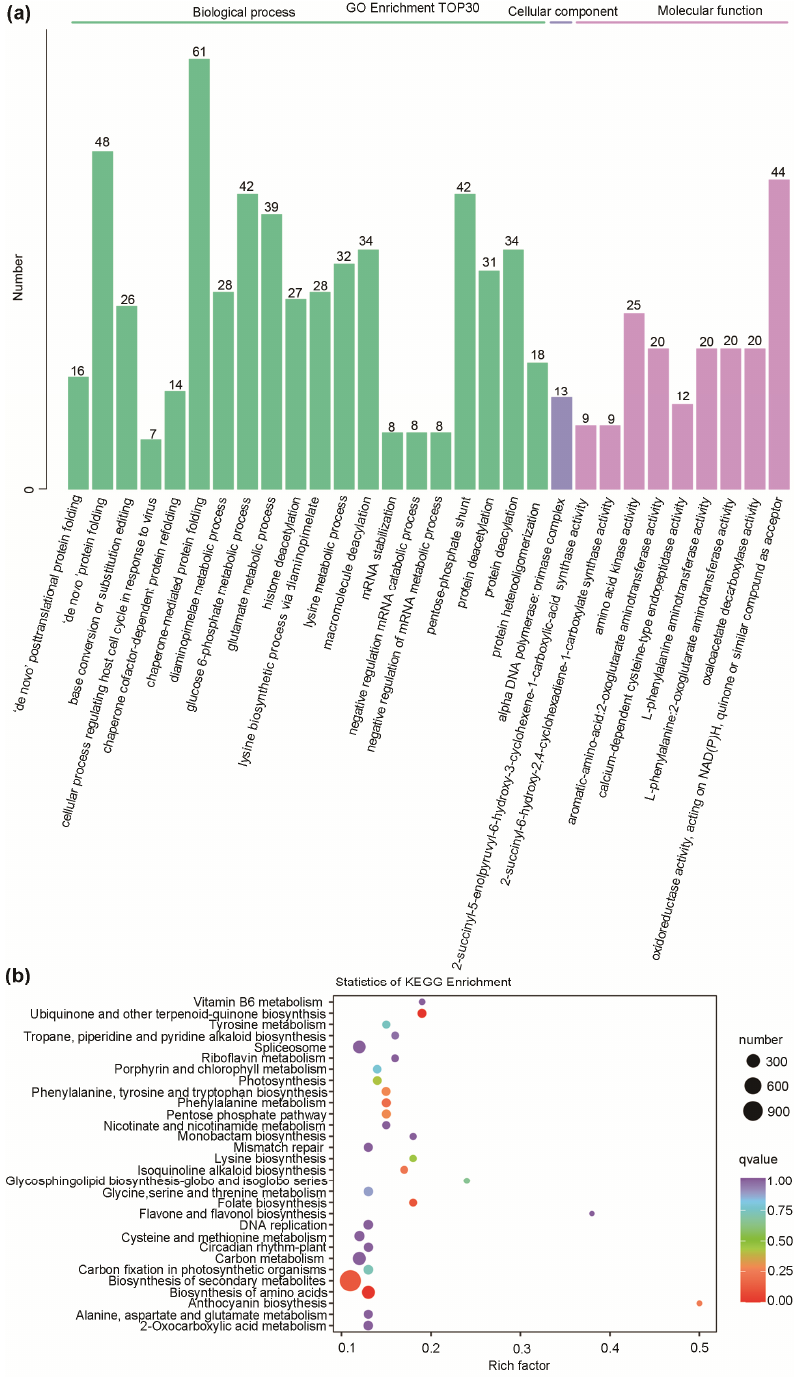
Figure 4. GO and KEGG analyses of differentially expressed genes (DEGs). ( a ) Top 30 of GO enrichment. ( b ) Scatter plot of top 30 KEGG − enriched pathways. The degree of enrichment is identified by rich factor, q − value, and the number of DEGs in each pathway.